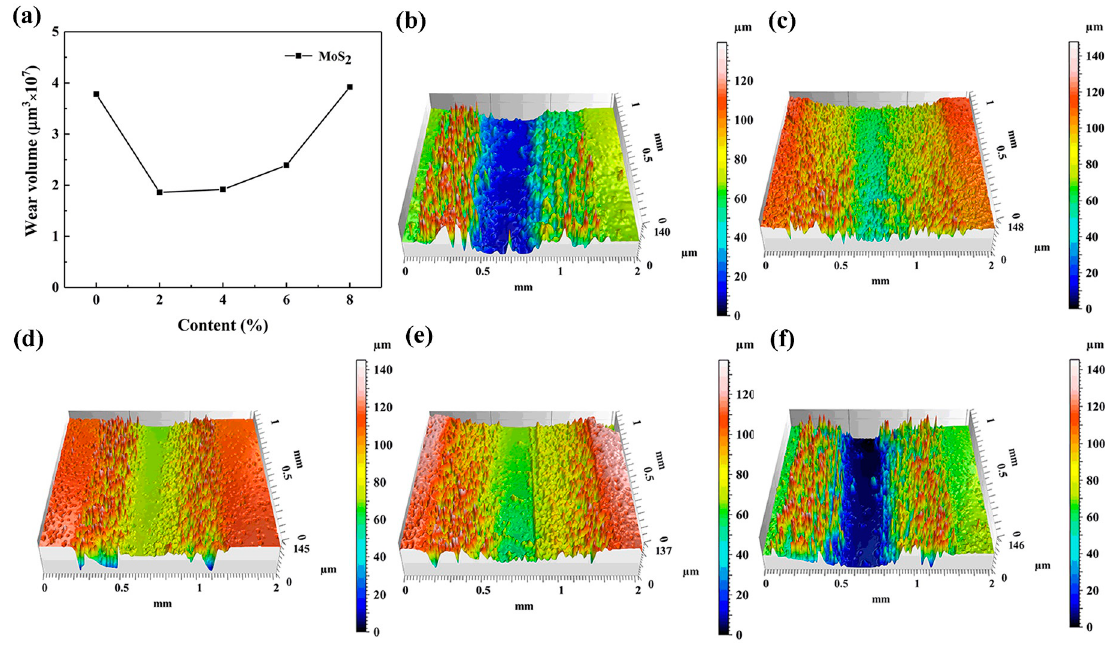
Figure 7. Wear volume curves and 3D wear profile of the original epoxy resin and epoxy resin composites with different MoS 2 content. ( a ) Wear volume curve, ( b ) 0% MoS 2 , ( c ) 2% MoS 2 , ( d ) 4% MoS 2 , ( e ) 6% MoS 2 , and ( f ) 8% MoS 2